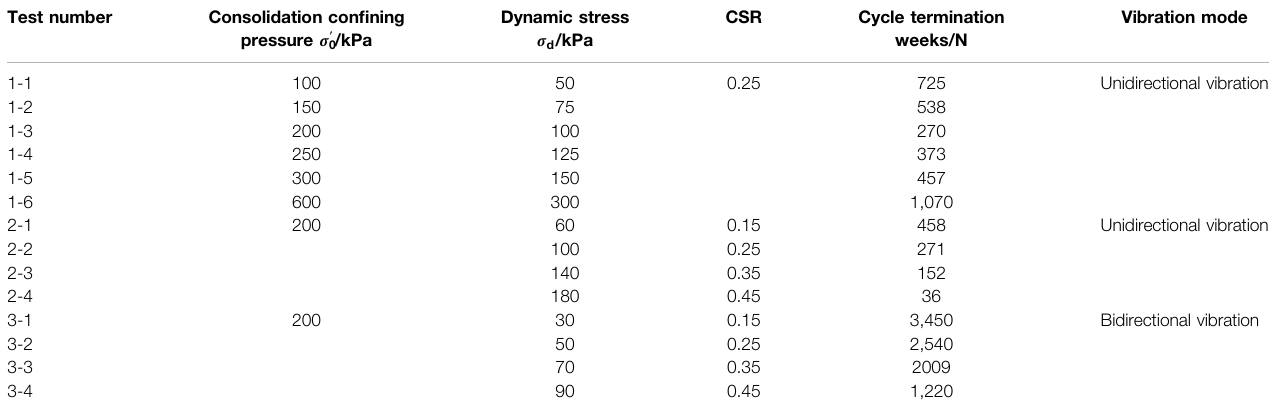
TABLE 2 | Test scheme.